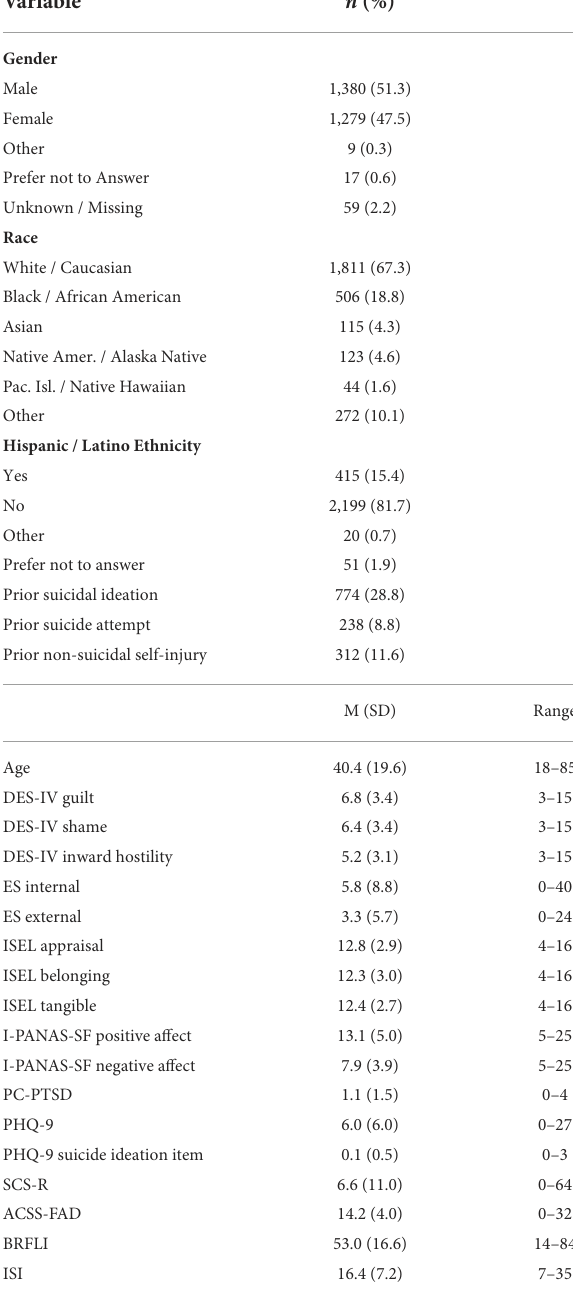
TABLE 1 Sample demographics and clinical descriptors. TABLE 2 Results of ICP models predicting occurrence of suicidal behavior during 1-year